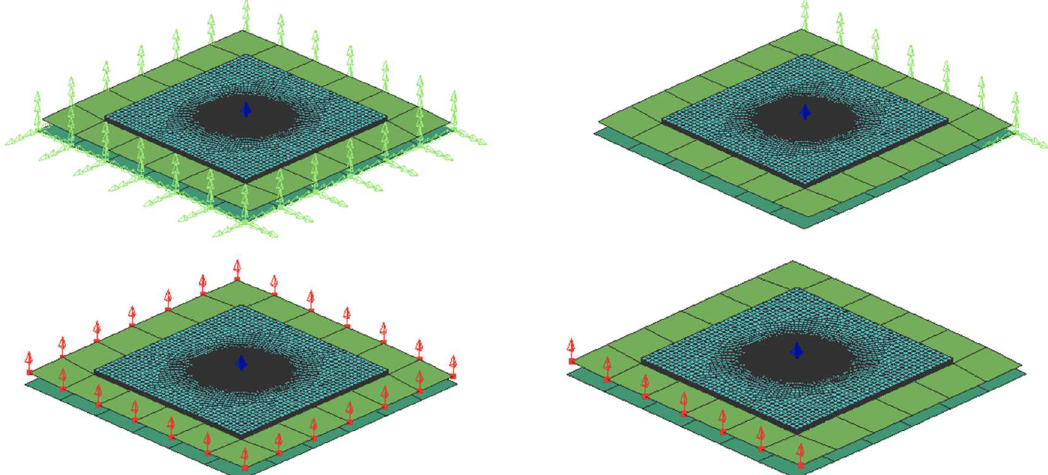
Fig. 25. Spot-weld supporting conditions (green arrows in the figures at the top) and enforced displacements (red arrows in the figures at the bottom) for two different loading typologies: left and right